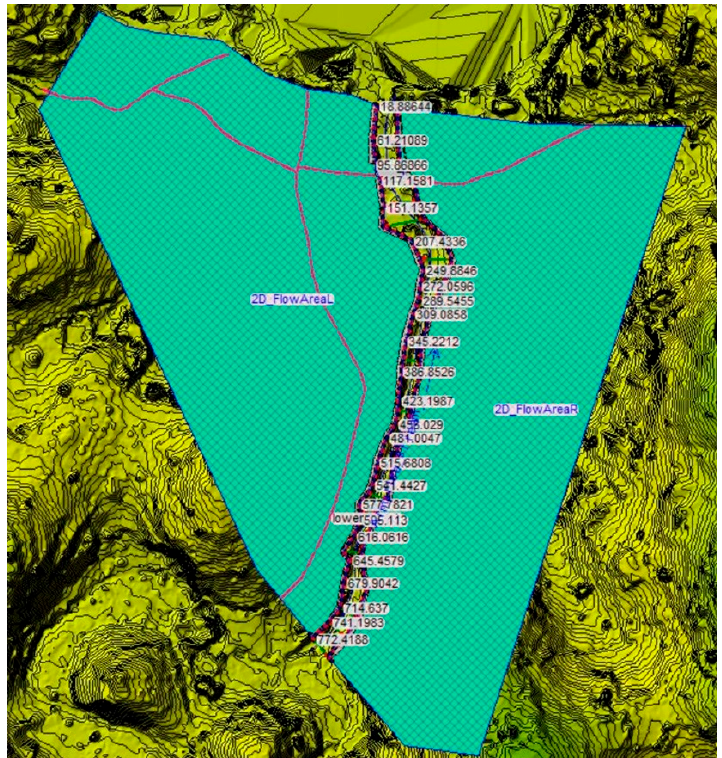
Figure 2. Geometry of the study reach, including the 2D flow areas, break-lines (pink), and 2D finite elements on the left and right of the 1D stream, through high-resolution digital elevation model (DEM) 2 m × 2 m.